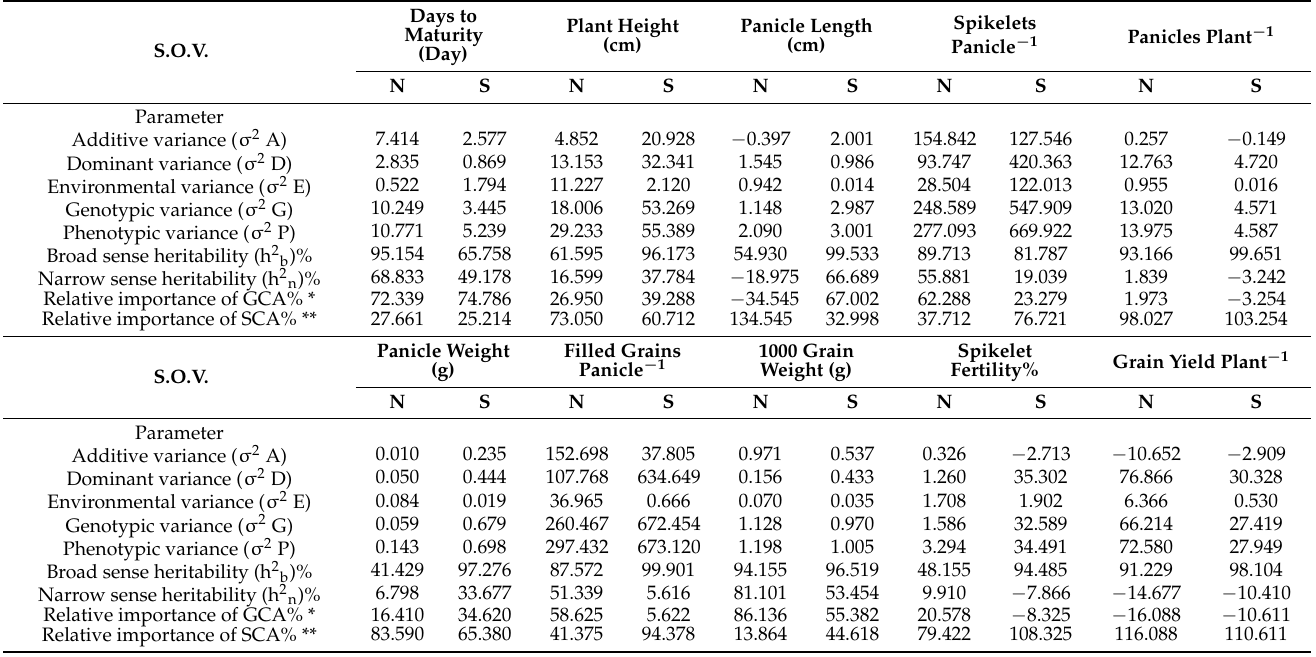
Table 2. Genetic Parameters for 10 Yield Characteristics Under Normal and Water-Stress